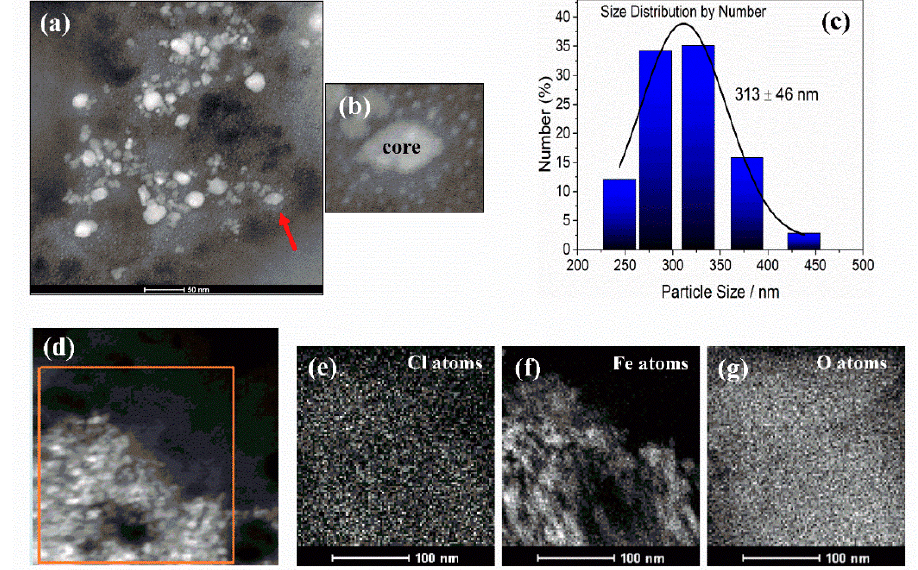
Figure1. Characterizationoftheironoxidenanoparticles-chitosan-cetylpyridiniumchloridenanocarrier. Transmission electron microscopy images ( a , b , d ) and size distribution histogram obtained by dynamic light scattering ( c ) for the nanocarrier. Image “b” represents an increase in the area highlighted with the red arrow in image “a”, where it is possible to clearly observe the cetylpyridinium chloride particles adhered to the core of iron oxide nanoparticles coated with chitosan. The orange area in image ( d ) was analyzed by X-ray energy-dispersive spectroscopy and allowed the identification of chlorine ( e ), iron ( f ) and oxygen ( g )